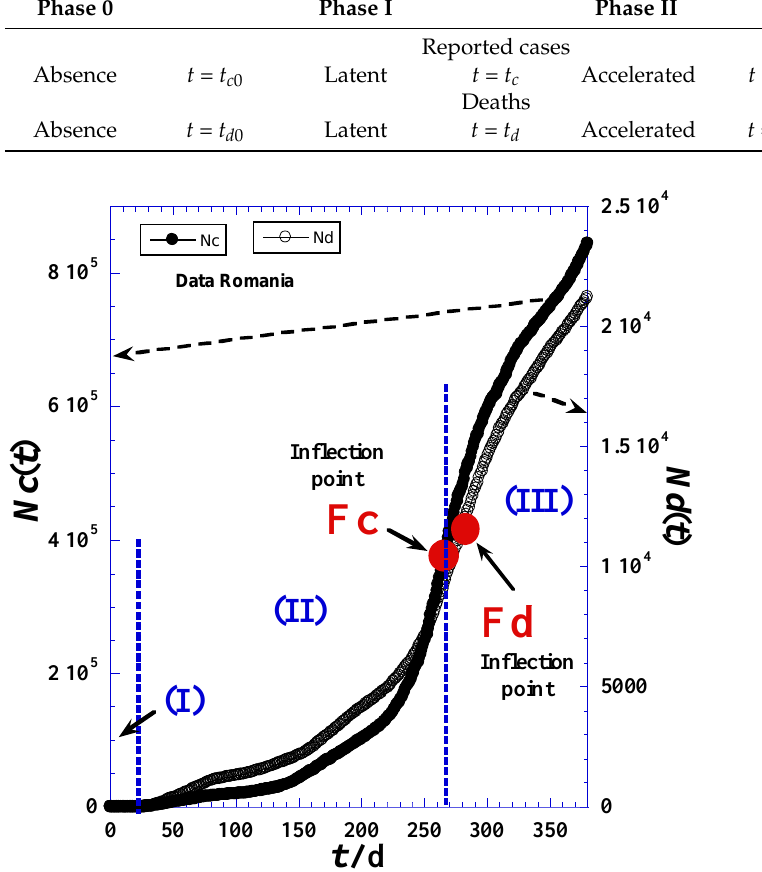
Figure 1. Total reported cases and deaths for the first 440 days of the pandemic in Romania. Table 1. Different spread phases and identification of the accelerated phase for the reported cases and deaths.